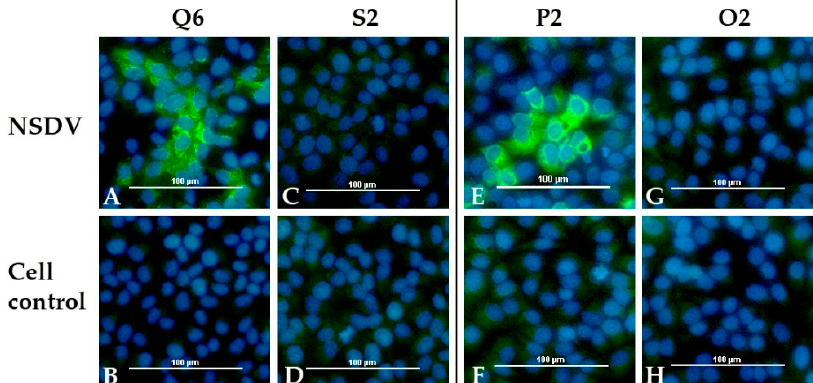
Figure 8. NSDV immunofluorescence assay: Results for one infected calf (Q6) and one infected sheep (P2) are presented together with the results for the mock control animals (calf S2 and sheep O2). Specific staining is shown for both infected animals on cells infected with NSDV (Q6: A , P2: E ). No signal was detected for the control animals (S2: C , O2: G ) and for all animals for non-infected cells (Q6: B , S2: D , P2: F , O2: H ).